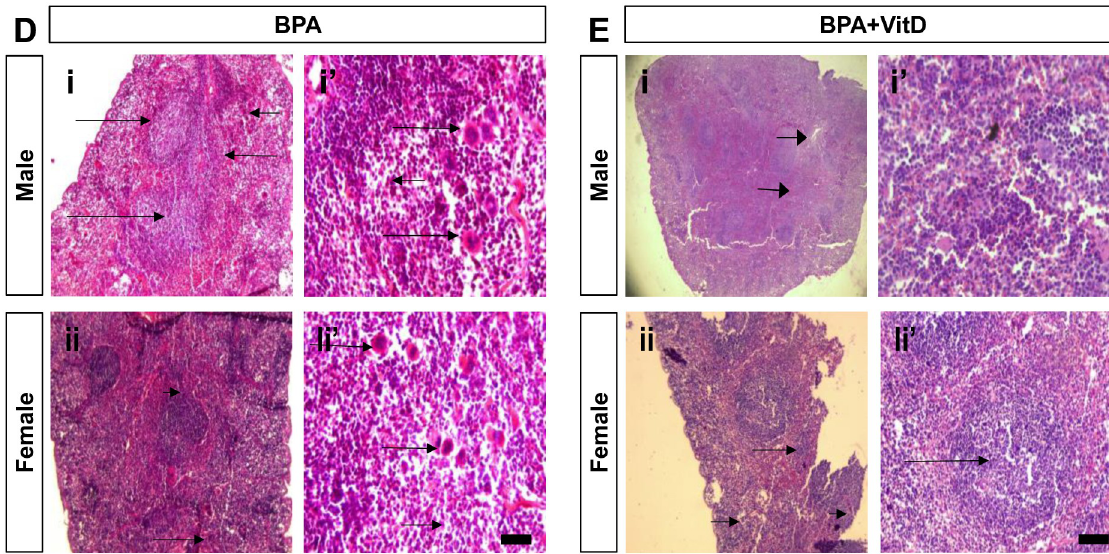
Fig 7. Histopathological analysis in hematoxylin and eosin (H&E) stained spleen of the BPA-treated mice and BPA+VitD-treated mice (40 × ). (D) The splenic tissues of male and female BPA-treated mice at lower magnification (panels Di and ii) showed hyperplasia of the splenic lymphoid follicles within the white pulp (long arrow), and the red pulp showed dilatation and congestion of the splenic blood vessels (short arrow). At lower magnification, the splenic tissues of male and female BPA-treated mice (panels Di’ and ii’) showed significant hyperplasia of the splenic lymphoid follicles (long arrow) surrounded by marked red pulp congestion (short arrow) and macrophage accumulation at the periphery of the tissues (long arrow) and massive hemosiderosis (short arrow). (E) The splenic tissues of male and female BPA+VitD-treated mice at lower magnification (panels Ei and ii) revealed hyperplasia of the splenic lymphoid follicles, surrounded by congested sinusoids with macrophage accumulation. At higher magnification, the splenic tissues of male and female BPA+VitD-treated mice (panels Ei’ and ii’) showed marked sinusoidal congestion with macrophage accumulation.